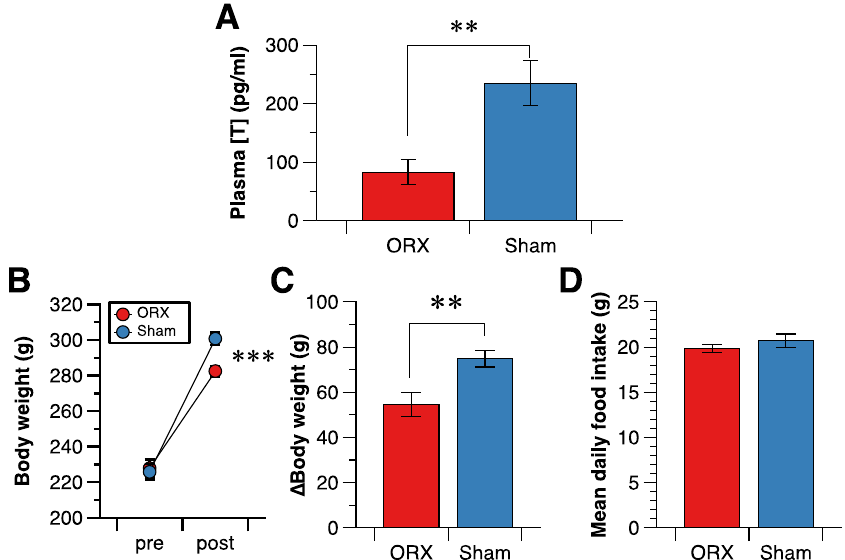
Figure 1. Effect of orchiectomy on plasma testosterone concentration and on body weight and daily food intake in male rats. ( A ): plasma testosterone concentration 21 days after the orchiectomy/sham operation. ( B ): Body weight before (pre) and 14 days after (post) orchiectomy/sham operation. ( C ): Change in body weight from before to 14 days after orchiectomy/sham operation. ( D ): Mean daily food intake for seven days after the 7-day recovery from the orchiectomy/sham operation ( n = 6 in each group). Data are shown as the mean and SE ( n = 11 in each group). ** and ***: significant dif- ference between the ORX group and the Sham group at p < 0.01 and p < 0.001, respectively.